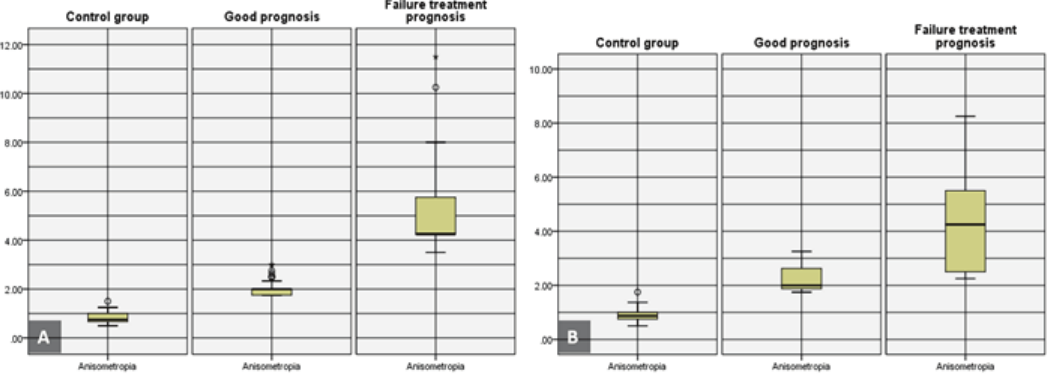
Figure 2. The box plot distribution of the anisometropia (diopter), categorized based on amblyopia treatment outcomes in the children (A) and adult (B)